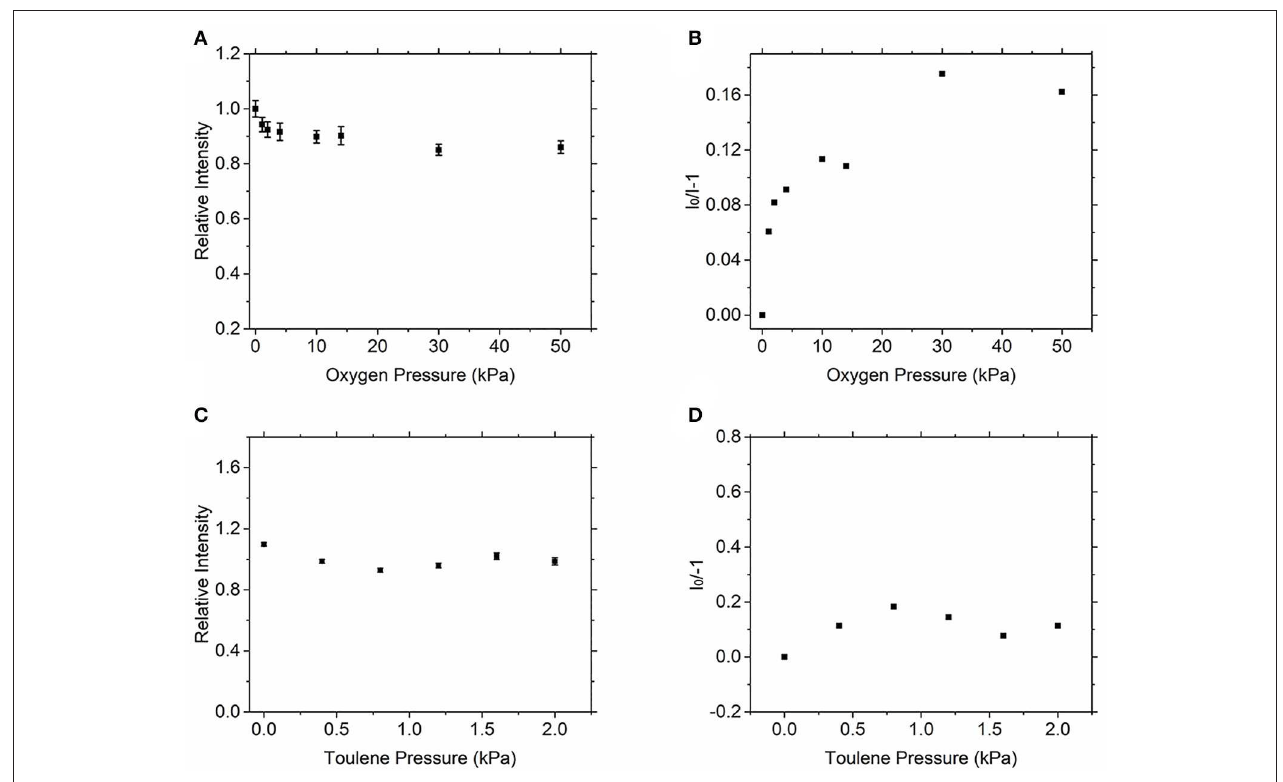
FIGURE 7 | The relationship between fluorescence intensity of acetone and toluene and partial pressure of oxygen.